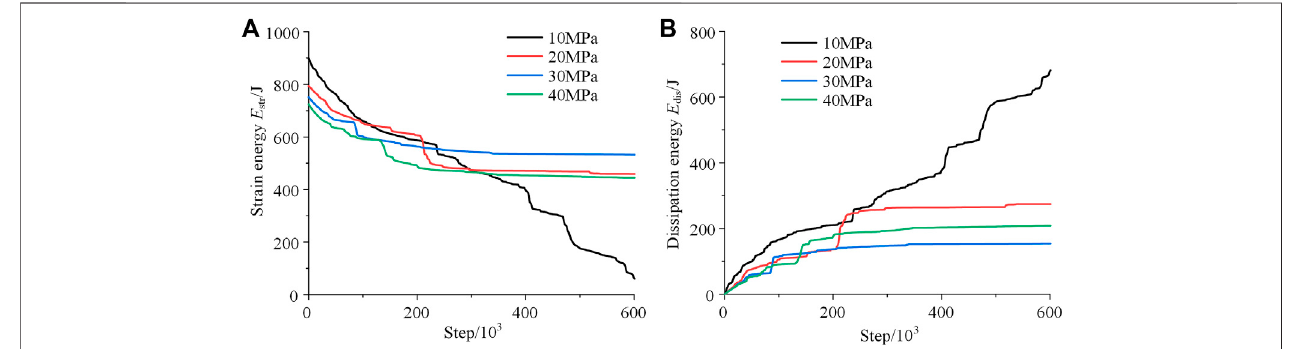
FIGURE 6 | (A) Energy release and (B) energy dissipation process of granite under different lateral stress.